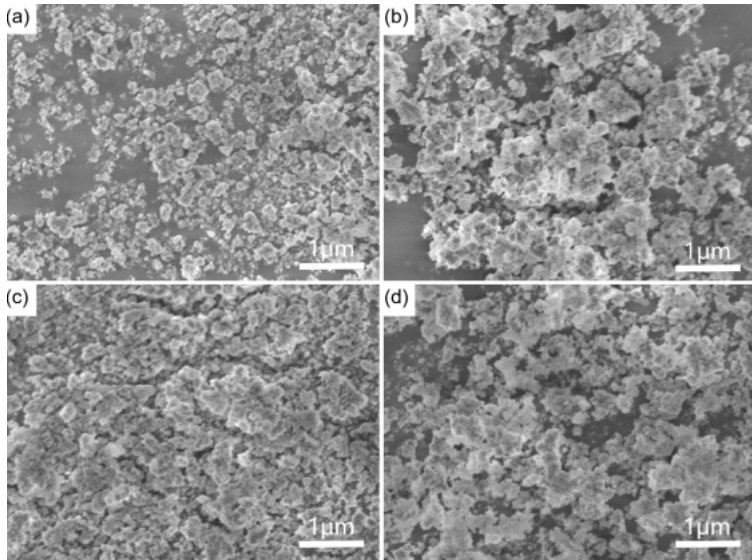
Figure 4. SEM images of SA ( a ), SA-NH 2 ( b ), SA-COOH ( c ), and SA-Ch ( d ).